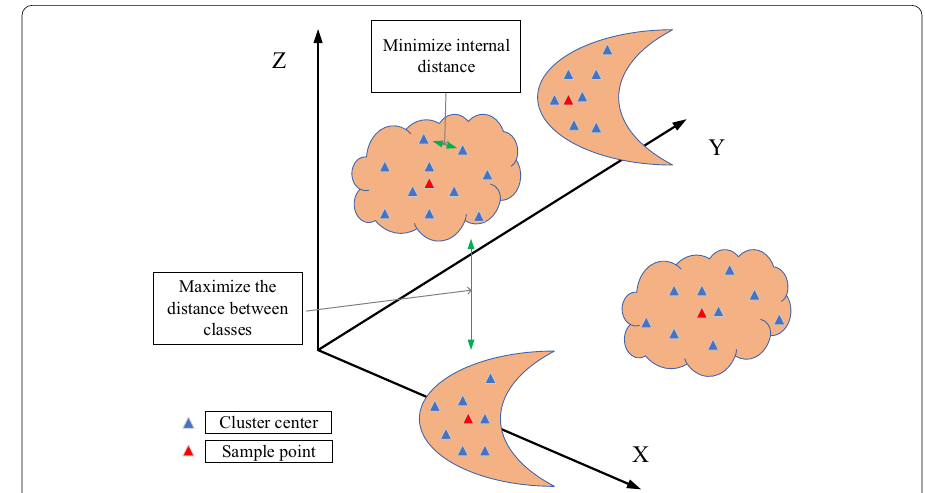
Fig. 1 Schematic diagram of cluster